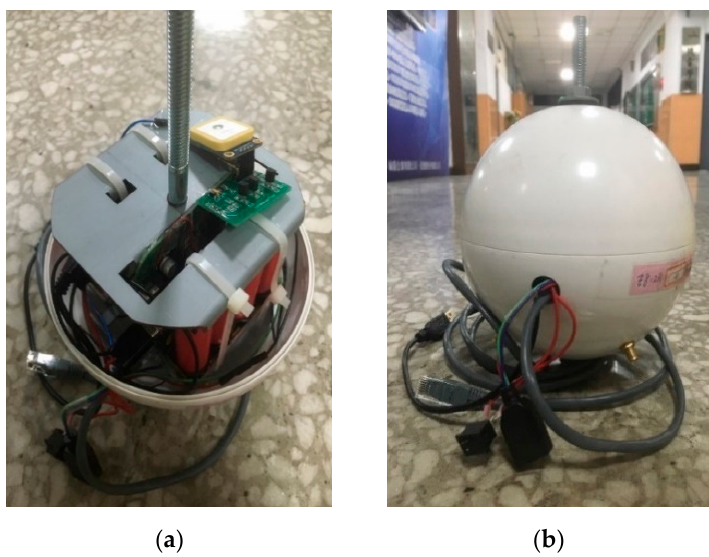
Figure 7. The Gateway. ( a ) The internal structure and ( b ) appearance.